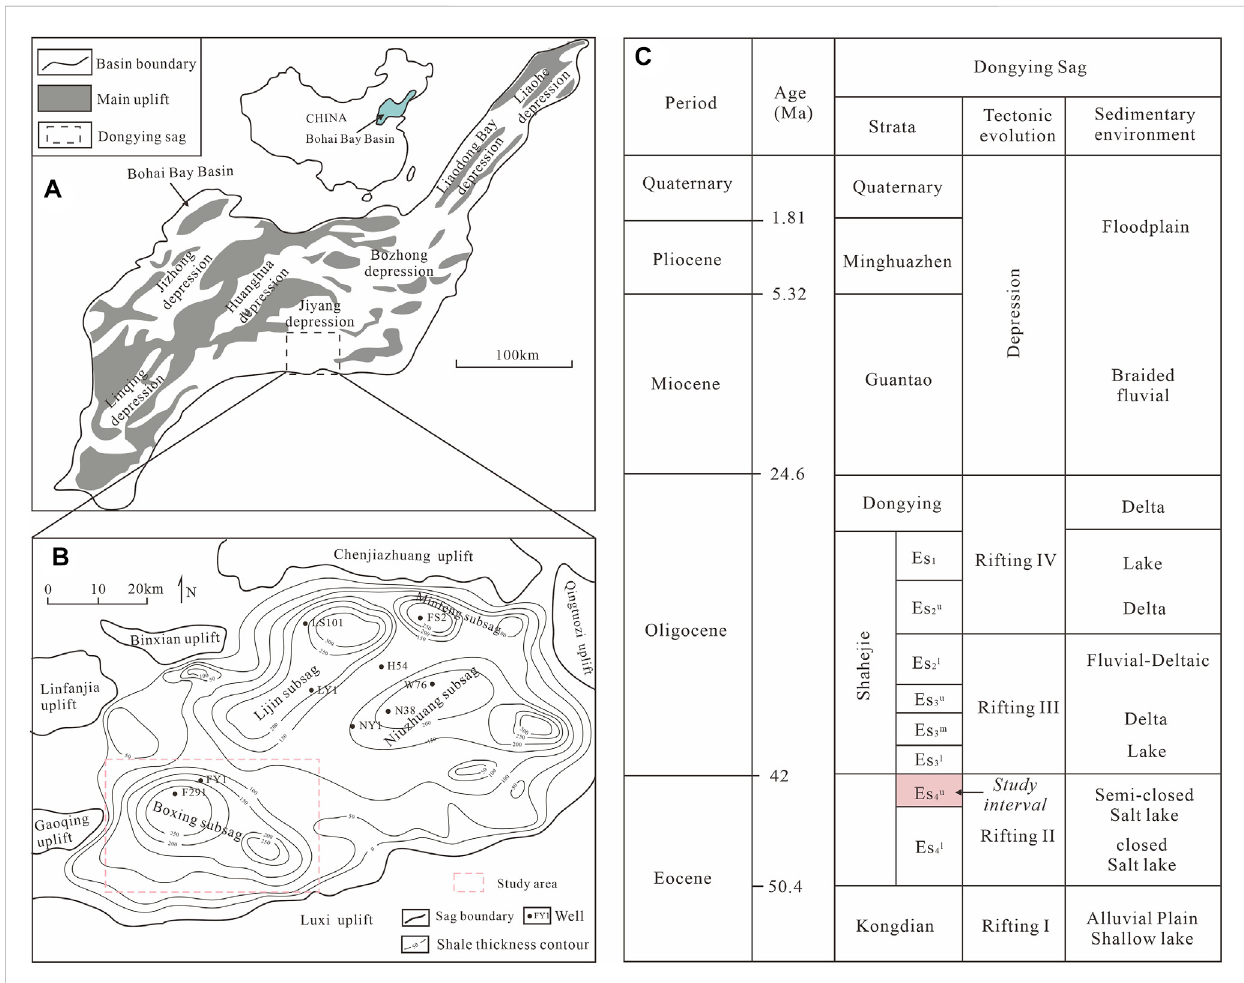
FIGURE 1 (A) Location, (B) shale thickness andwell distributions,and (C) stratigraphic column of Dongying Sag (quoted and modi fi edfromZhang